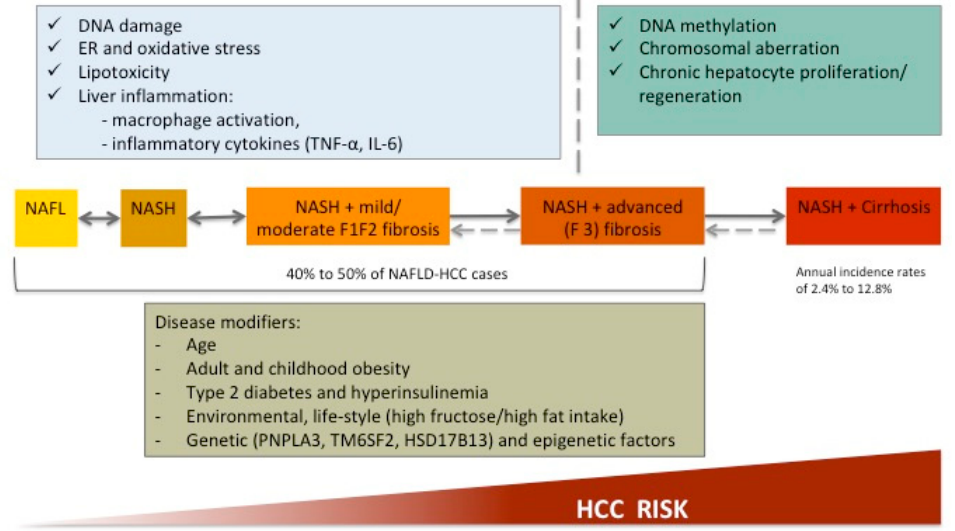
Figure 3. Mechanisms of carcinogenesis according to the presence/absence of cirrhosis and disease modifiers involved NAFLD-related HCC.